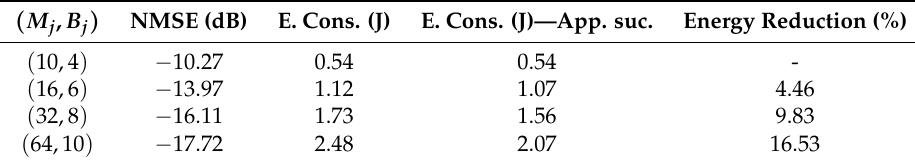
Table 4. Evaluation of the proposed successive approximation scheme capability to save sensor nodes energy—Scenario